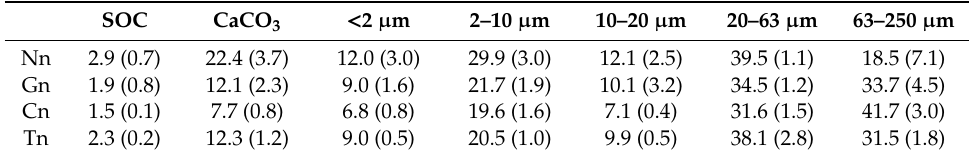
Table 1. The mean contents of topsoil properties in the experimental plots, natural area (N), grazing (G), conventional agriculture practice (C), and traditional agriculture practice (T), presented as w / w percentages: soil organic carbon (SOC), carbonates (CaCO 3 ), clay ( < 2 µ m), fine silt fractions (2–10 µ m), coarse silt (10–20 µ m), and sand (62–250 µ m). Standard deviation (S.D.) values are presented in brackets for each soil test ( n = 6).